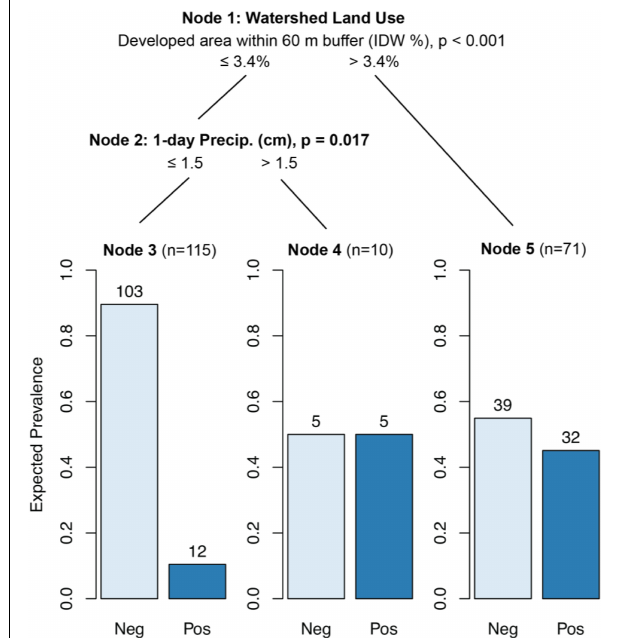
FIGURE 2 | Conditional inference tree (CTree) showing factors and combinations of factors predictive of HF183 (human) marker presence. In Node 1, IDW % developed area within 60 m buffer was designated the primary split ( p < 0.001), while developed watershed area (split = 41%, p < 0.002) and the presence of stormwater outfalls ( p < 0.012) were designated surrogate splits that split the data equally well. Node 2 had no significant